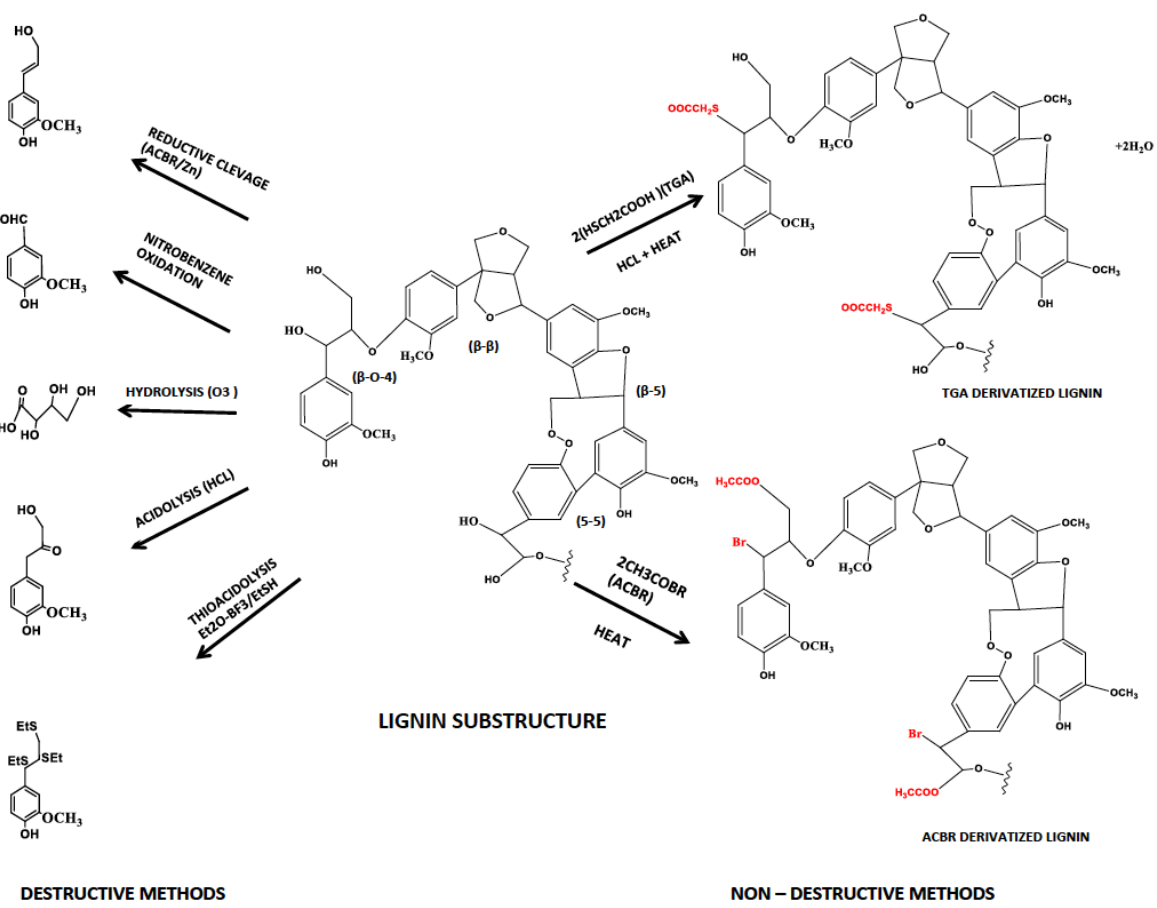
Figure 2. Lignin substructure and analytical methods. Destructive methods (acid hydrolysis, oxidation and reduction) result in breakdown products that can be used to quantify the